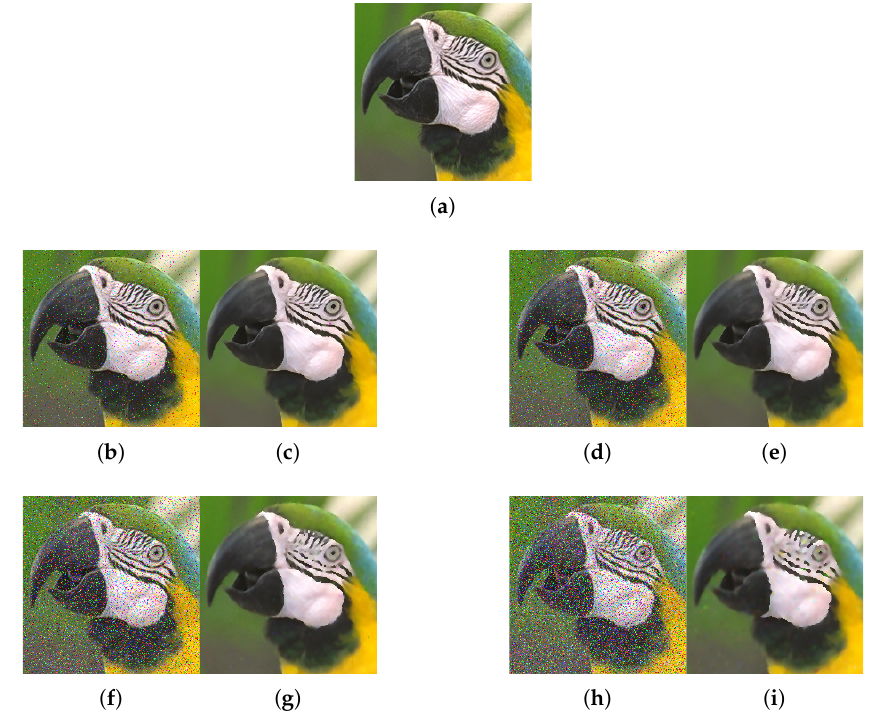
Figure 14. Method outputs using test image Parrots contaminated with various intensities of impulsive noise p . ( a ) Parrots. ( b ) Noisy p = 0.05. ( c ) Filter output. ( d ) Noisy p = 0.1. ( e ) Filter output. ( f ) Noisy p = 0.2. ( g ) Filter output. ( h ) Noisy p = 0.3. ( i ) Filter